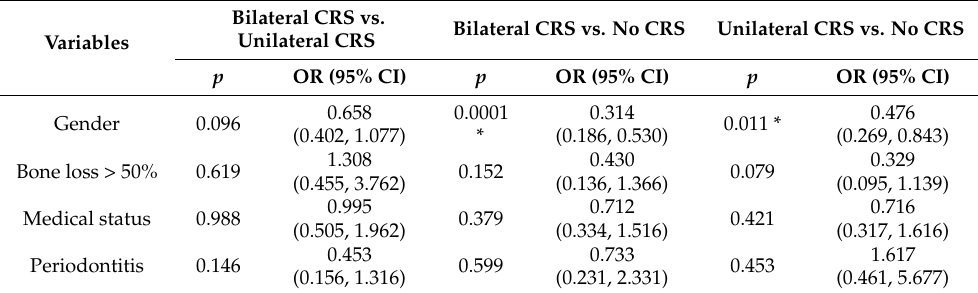
Table 4. Analyzing CRS as a three-level outcome (bilateral CRS, unilateral CRS, no CRS) under different characteristics using the generalized logistic model. Bilateral CRS vs. Unilateral Variables